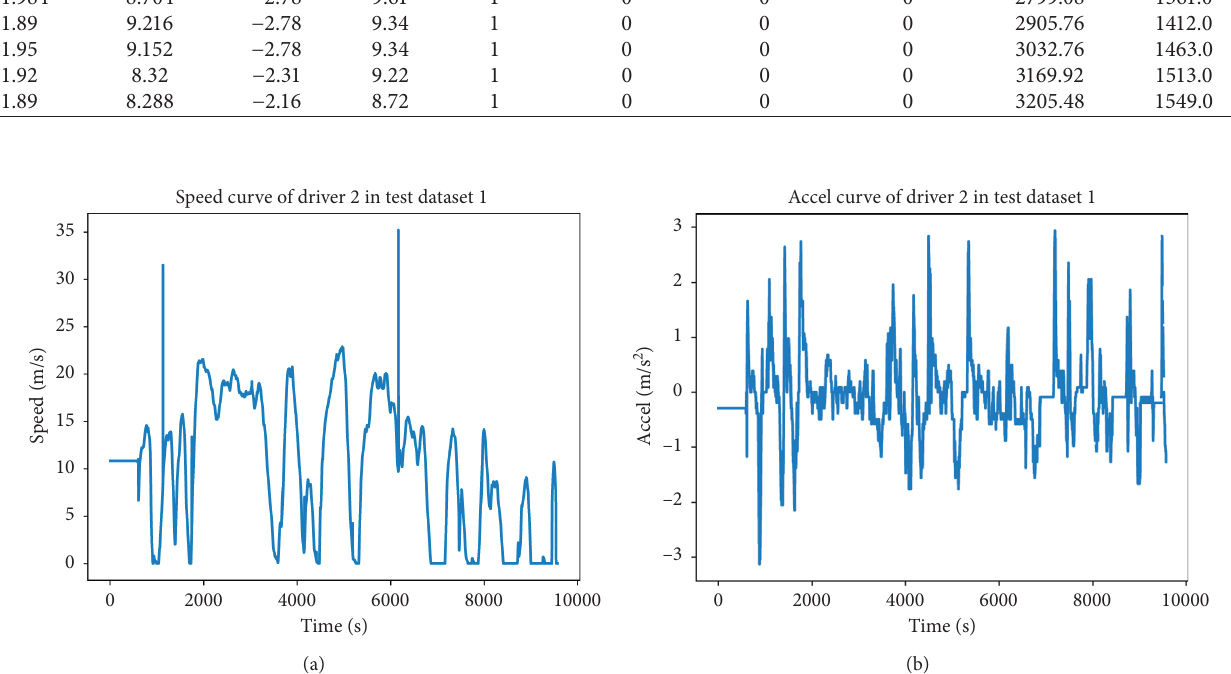
Figure 6: The driving sample of vehicle motion from Driver 2 in test dataset 1: (a) speed curve of three sample driving; (b) acceleration curve of three sample driving. Table 5: Results of driving styles identification average accuracy in test datasets. Model